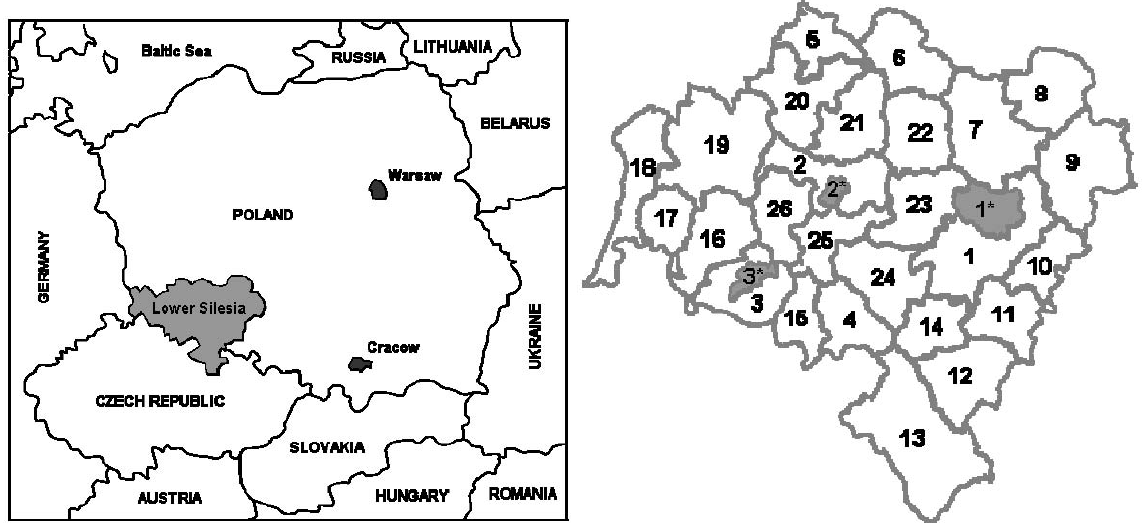
Fig. 1 Map of the Lower Silesian province and its division into counties (cities with county rights are indicated with an asterisk): 1, 1*, Wroc(cid:2)law; 2, 2*, Legnica; 3,